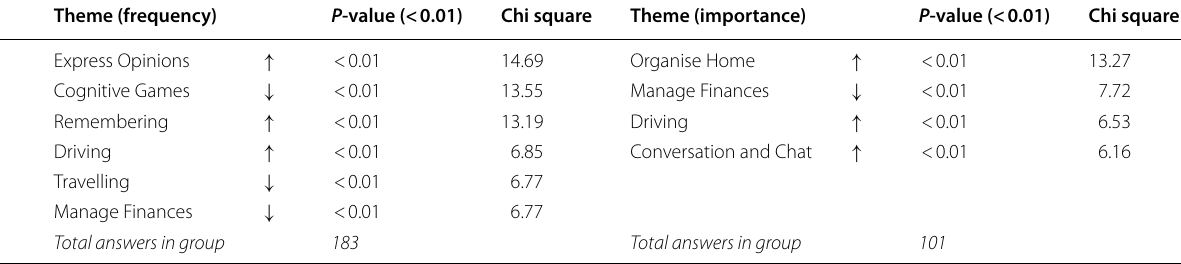
Representing themes where respondents in the Diagnosis group are more likely to either report this theme as something that matters to them (Frequency) or select ↑ this theme as one of the most important themes (Importance) Representing themes where respondents in the Diagnosis group are less likely to either report this theme as something that matters to them (Frequency) or select ↓ this theme as one of the most important themes (Importance)